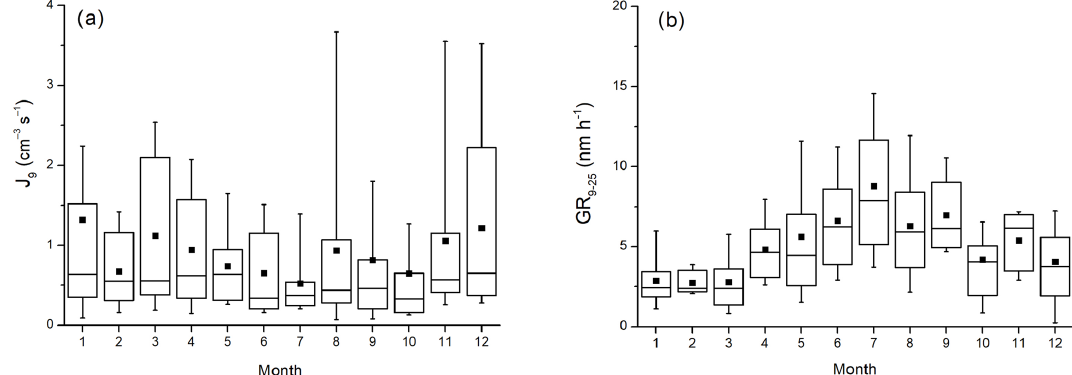
Figure 6. Seasonal variation in (a) formation rate of 9nm particles ( J 9 ) and (b) growth rate in the size range 9–25nm (GR 9–25 ) as calculated during Class I NPF events at Finokalia for the period June 2008–June 2018. Whiskers represent 10th and 90th percentiles, box edges are 75th and 25th percentiles, the horizontal line in the box is the median, and the solid square is the mean. Table 2. Formation rates for 9nm particles ( J 9 ), growth rates in the size range 9–25nm (GR 9–25 ) for NPF events observed at Finokalia and condensational sink for sulfuric acid (CS) on a seasonal basis during the period June 2008–June 2018 (mean, median and standard